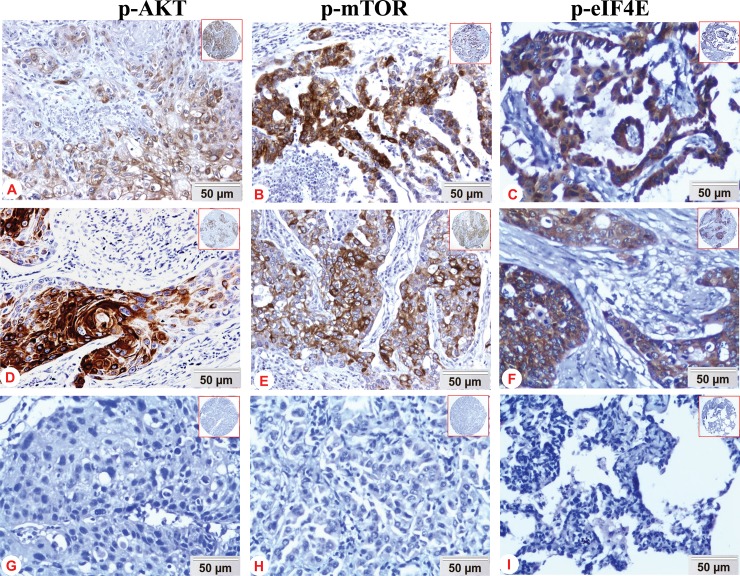
Expression of p-Akt, p-mTOR and p-eIF4E proteins in NSCLC and non-cancerous lung tissue was detected by immunohistochemistry.Positive expression of p-Akt was mainly located in the cytoplasm, a few in nucleus or membrane of lung ADC (Fig 1A) and lung SCC (Fig 1D); and no positive staining of IgG isotype-matched control antibody in lung SCC (Fig 1G); positive expression of p-mTOR was indicated mainly in the cytoplasm of lung ADC (Fig 1B) and lung SCC (Fig 1E); and negative expression of p-mTOR protein in lung ADC (Fig 1H); positive expression of p-eIF4E was predominantly located in the cytoplasm of lung ADC (Fig 1C) and lung SCC (Fig 1F); no positive expression of p-eIF4E protein in non-cancerous lung tissue (Fig 1I) (DAB staining, magnification 200×).